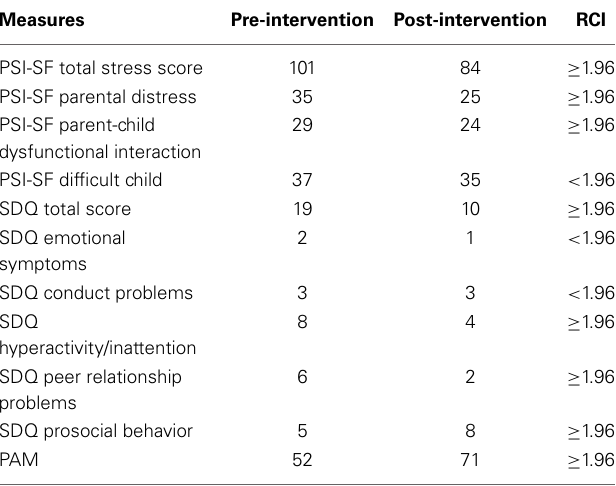
Table 1 | Father’s self reports scores pre- and